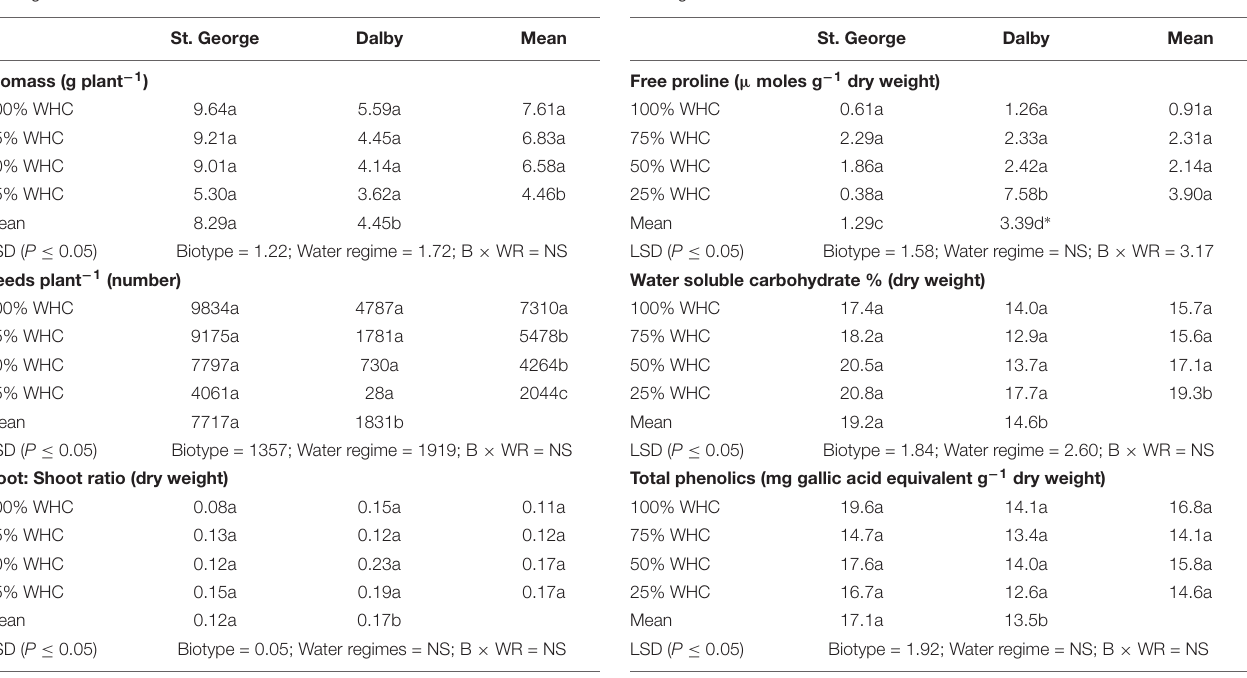
TABLE 3 | Effect of different soil moisture levels (factor 2) on different parameters of two Australian Biotypes (St. George and Dalby; factor 1) of Sisymbrium thellungii .Moisture